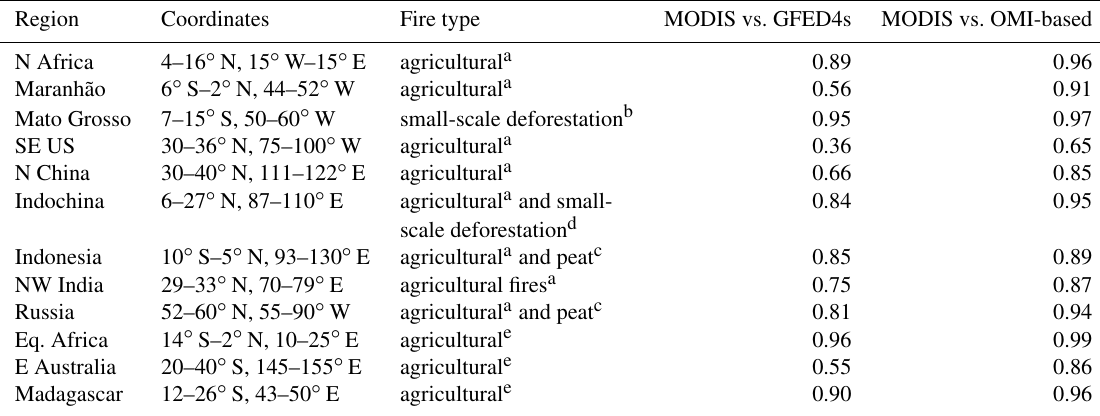
Table 3. Temporal correlation between monthly MODIS fire counts, GFED4s, and OMI-based fluxes over the regions selected based on literature evidence for the occurrence of small fires. The regions are shown on the MODIS land cover map in Fig. S4.